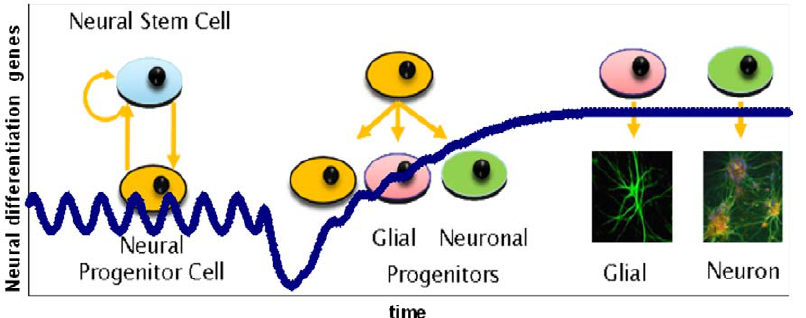
Figure 9. Dynamic evlolution of the pathway during commitment to a specific lineage and differentiation. The up-regulation of Mash1 is matched by an up-regulation in Hes6, which in turn further alleviates the inhibitory effects of Hes1. While the oscillations are dampened, asymmetric division is expected. The oscillatory behaviour induced by the Notch pathway will be alleviated after differentiation and the levels of expression should remain constant as the model describes.